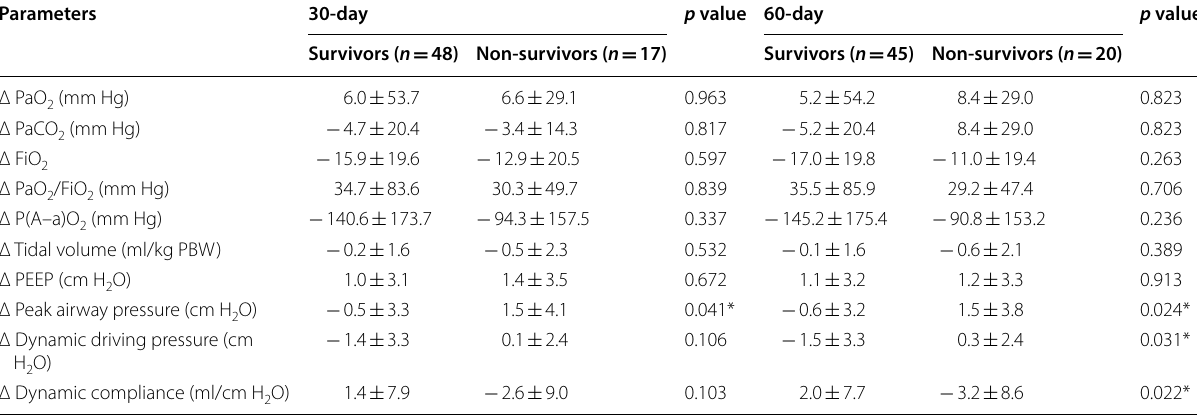
Table 2 Change in gas exchange and lung mechanics between survivors and non-survivors for influenza pneumonia- related ARDS